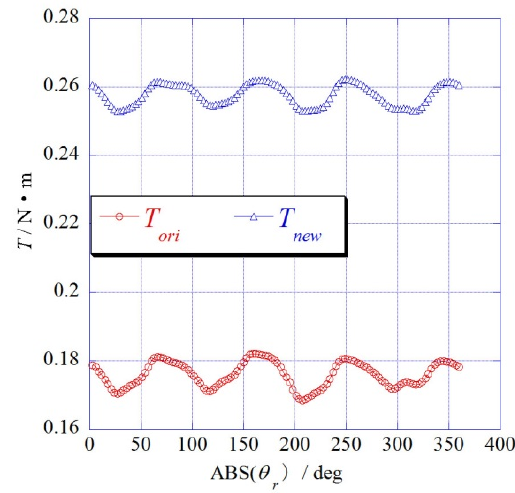
Figure 17. Comparison between the rear rotor’s torque.